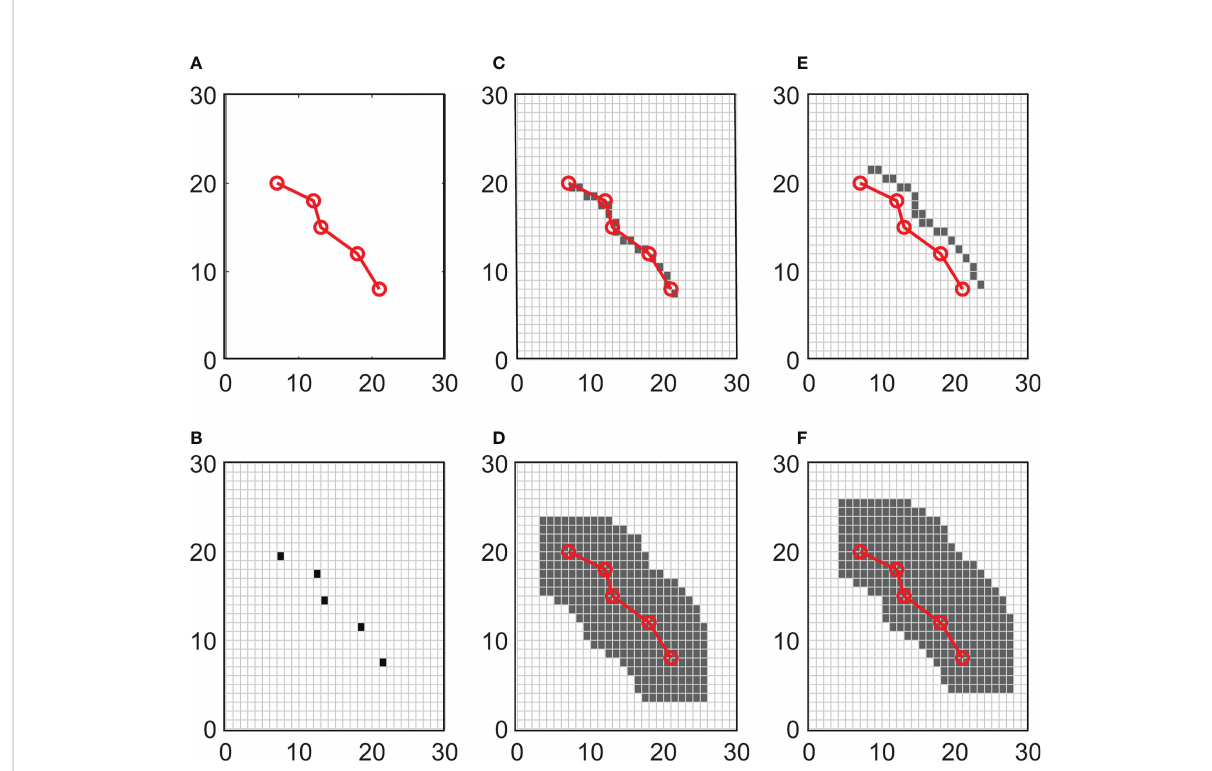
FIGURE 2 Schematic diagram of the TC-in fl uenced area determined by Bresenham ’ s line algorithm. (A, B) TC track points are plotted as a grid on a 0.04° × 0.04° gridded map; (C) the approximation line of the original TC track is drawn using Bresenham ’ s line algorithm. (D) TC-in fl uenced area of equal width is obtained; (E) parallel shifting this approximate trajectory; (F) the TC-in fl uenced area that extended 1° leftward and 2° rightward from the TC